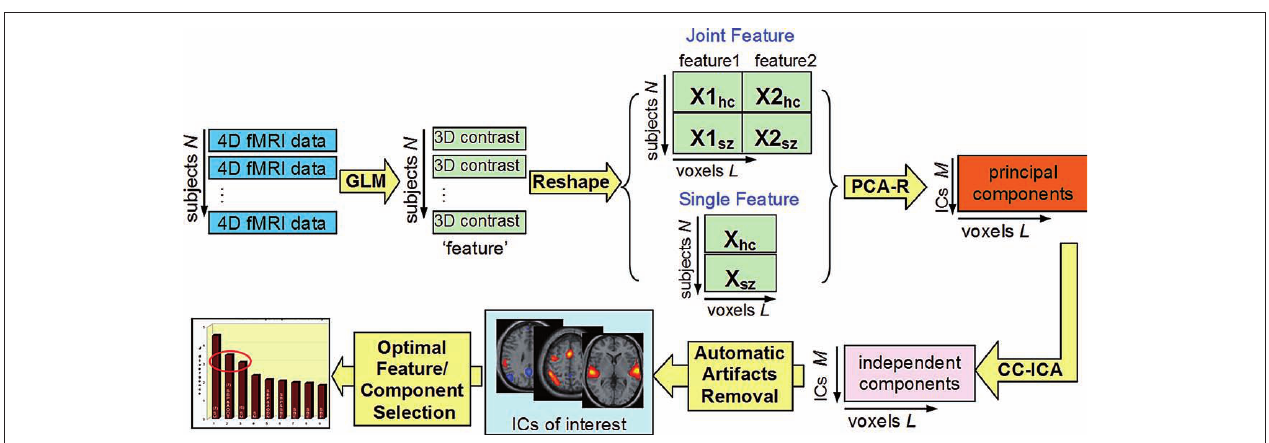
FIGURE 8 | An analysis fl ow chart showing the process of obtaining optimal group discriminative components (from Sui et al., 2009b). Flowchart of the optimal features/components selection, explaining how to determine the fi nal optimal components from the raw